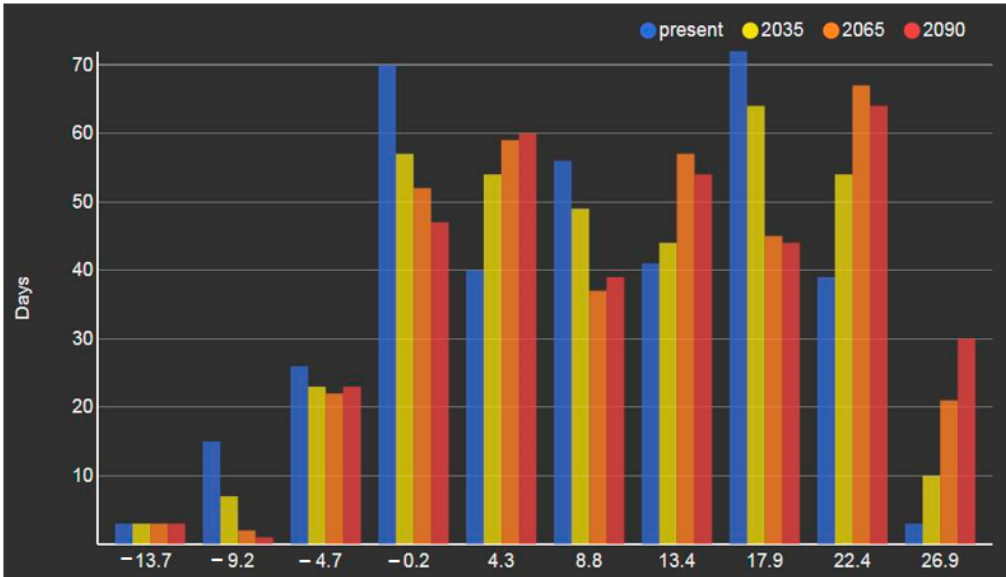
Figure 6. Projected weather data for Timi ș oara location based on RCP 4.5 and 50% warming percentile representing the shift of the number of days of average daily temperature. Reprinted from [27].